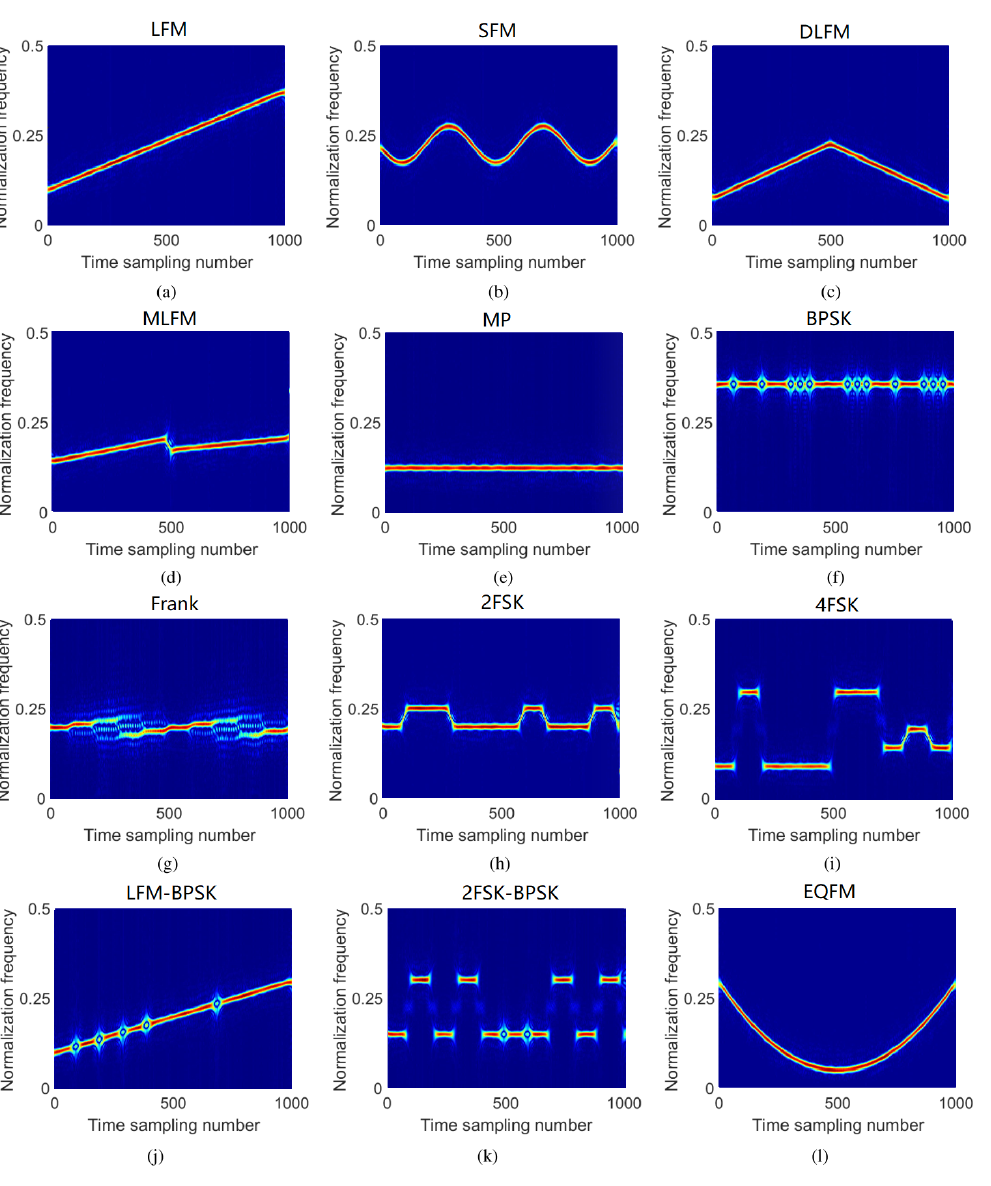
Figure 7. TFIs of different modulation modes: ( a ) LFM; ( b ) SFM; ( c ) DLFM; ( d ) MLFM; ( e ) MP; ( f ) BPSK; ( g ) Frank; ( h ) 2FSK; ( i ) 4FSK; ( j ) LFM-BPSK; ( k ) 2FSK-BPSK; ( l )